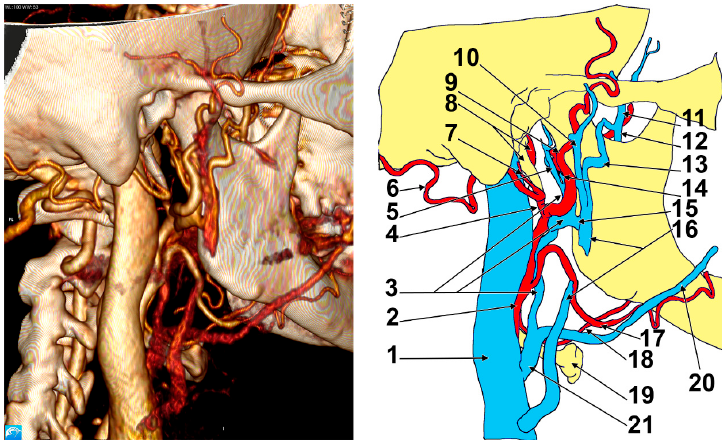
Figure 3. Right postero-infero-lateral view of the retromandibular fossa. Three-dimensional volume rendering and draw- ing. 1. Internal jugular vein; 2. external carotid artery; 3. Launay’s external carotid vein; 4. occipitoauricular trunk; 5. ret- rocondylar vein; 6. occipital artery; 7. posterior auricular artery; 8. internal carotid artery, styloid process; 9. superficial temporal artery; 10. superficial temporal vein; 11. deep temporal venous trunk; 12. communicating vein with the maxillary vein; 13. extracondylar vein; 14.maxillary vein; 15. intraparotid communicating vein; 16. external jugular vein (inter- rupted); 17. facial artery; 18. lingual artery; 19. hyoid bone; 20. proper facial vein; 21. common facial vein. At 0.39 cm before joining the superficial temporal vein, the maxillary vein sent off an inferior trunk that was joined by a retrocondylar vein to form Launay’s ECV. The initial Medicina 2021 , 57 , 985 segment of the ECV was anteromedial to the ECA’s terminal segment. Then, it anasto- mosed with the EJV and continued along the ECA and in front of it. In that course, the ECV crossed medially to the facial artery and joined the FV to form a common trunk (com- mon FV) of 1.05 cm in length, which crossed anteriorly to the carotid bifurcation and ended in the IJV. An additional anatomic variant was found on the right side: an occipitoauricular trunk left of the ECA that further divided into the occipital and posterior auricular arter- ies.